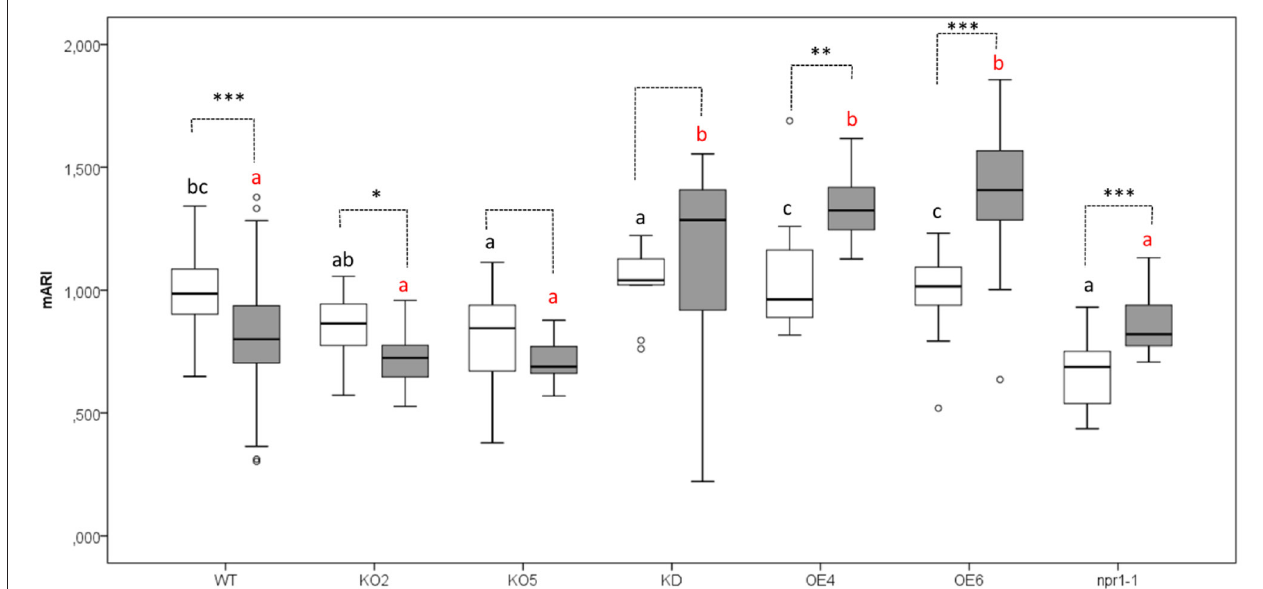
FIGURE 7 | Anthocyanin content (AriIdx) in 17-day-old Arabidopsis plants at 3 days after Pst DC3000 inoculation. Graphs show mean values with error bars representing standard deviation. For this graph, values of all plant lines and treatments were normalized to the WT Mock of each experiment, allowing us to represent two different experiments together in one graph. White boxes represent mock-treated samples and gray boxes Pst DC3000 infected samples. Comparison of Arabidopsis lines within Pst DC3000 treated plants (red letters), or mock-infected plants (black letters) was done with a one-way ANOVA analysis followed by a post-hoc Tukey test. Significant letters indicate differences at a level of p < 0.05. The comparison between mock and Pst DC3000 infected plants within a plant genotype was done using independent samples T -test for normally distributed data and Mann-Whitney test for non-normally distributed samples. Asterisks indicate statistically significant differences between treatments within the same transgenic line (* p ≤ 0.1; ** p ≤ 0.05; *** p ≤ 0.001). Number of observations (individual rosettes) in mock treatment: WT = 36, OE6 = 18, OE4 = 12, KD = 10, KO2 = 18, KO5 = 18, npr1-1 = 18. Number of observations (individual rosettes) in Pst DC3000 infection treatment: WT = 48, OE6 = 24, OE4 = 12, KD = 10, KO2 = 18, KO5 = 18, npr1-1 =